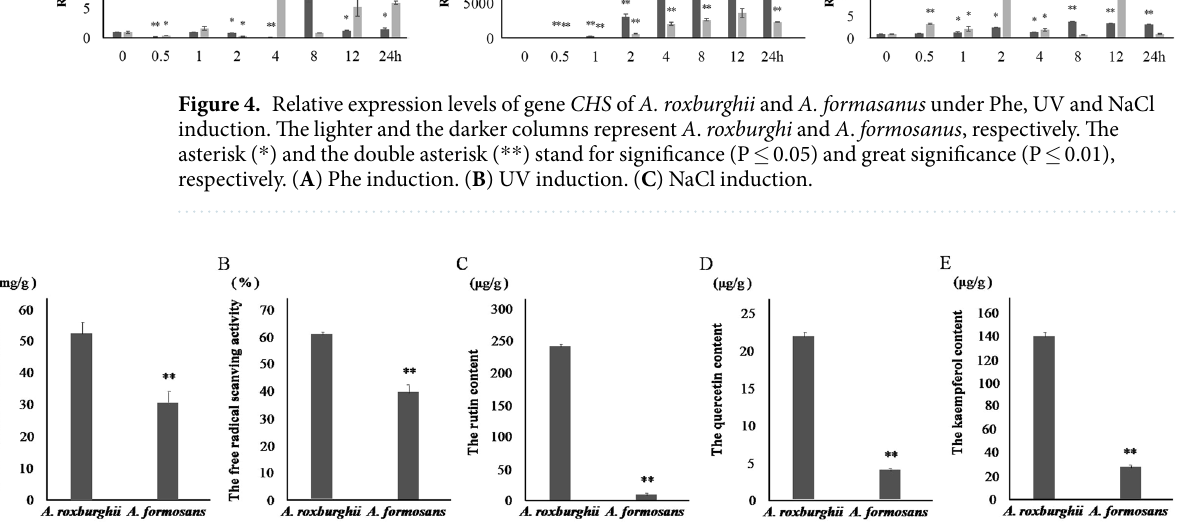
Figure 5. Content of total flavonoids and flavonols, and FRSA in A. roxburghii and A. formosanus under non inducing condition. The asterisk ( * ) and double asterisk ( ** ) stand for significance with the control at 0.05 and 0.01 levels, respectively. ( A ) Content of total flavonoids. ( B ) FRSA. ( C ) Content of flavonols (rutin, quercetin and